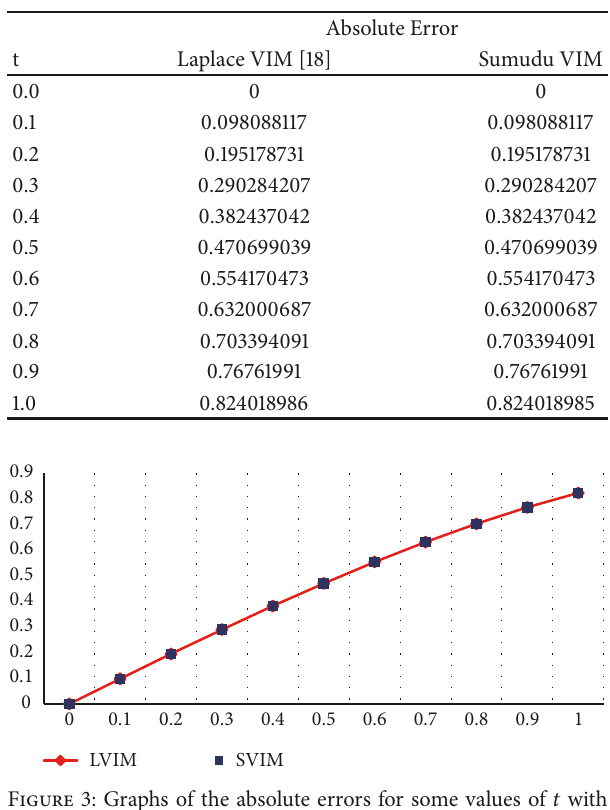
Figure 3: Graphs of the absolute errors for some values of 𝑡 with LVIM and SVIM for Example